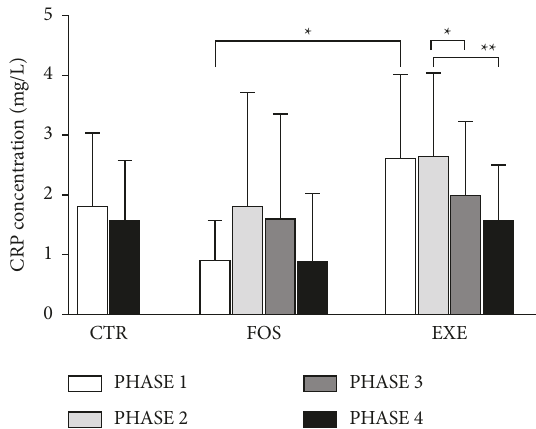
Figure 1: CRP concentration (mg/L) analysis in celiac disease patients and healthy people. CTR—healthy control group, n FOS—CD patients submitted to fish oil supplementation, n and EXE—CD patients submitted to fish oil supplementation and aerobic exercise, n (cid:31)